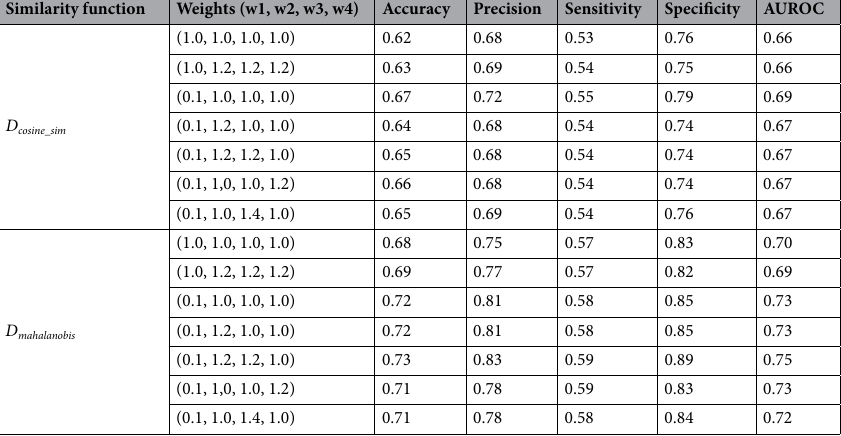
Table 3. Comparison of the performances of multi-resolution patch-based anomaly detection methods.